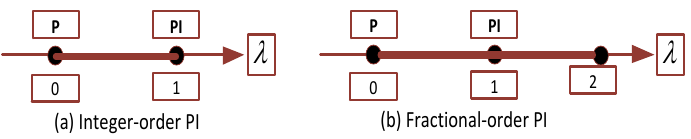
Figure 5. The integer order and fractional order PI.